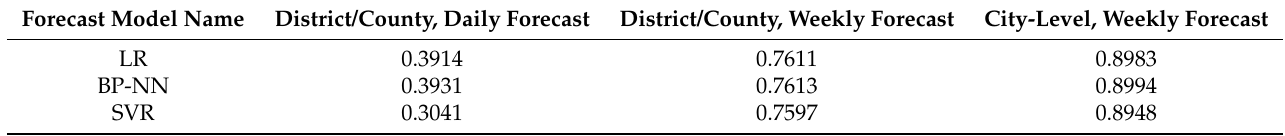
Table 2. Experimental results of different time precision and spatial precision prediction. Forecast Model